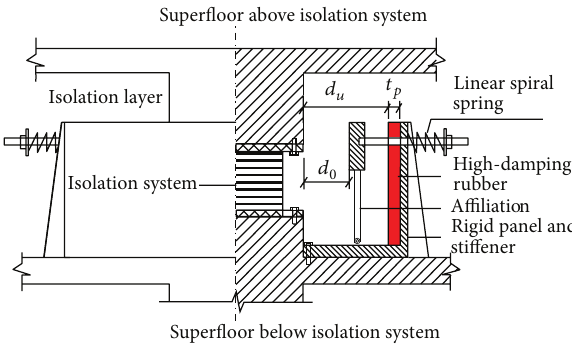
Figure 1: Protective system for limiting deformation of isolation